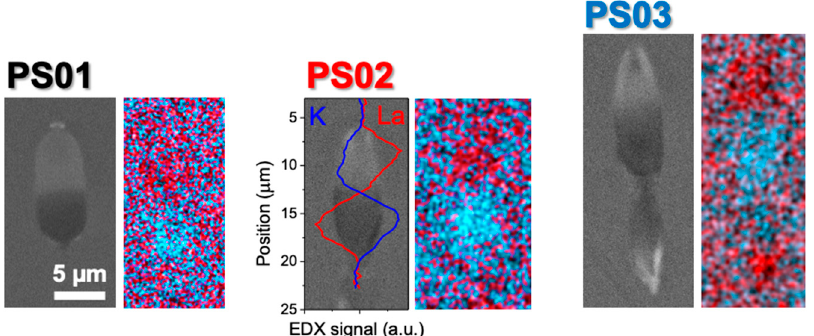
Figure 4. Scanning Electron Microscope (SEM) images and EDX maps of La (red) and K (blue) distribution in structures written at 695 nJ in samples (PS01, PS02, PS03) with different La 2 O 3 and K 2 O content. The plot is a cross section of the distribution of both species along a vertical line passing through the center of the structure written in the PS02 sample. The scale bar is the same for all the images.